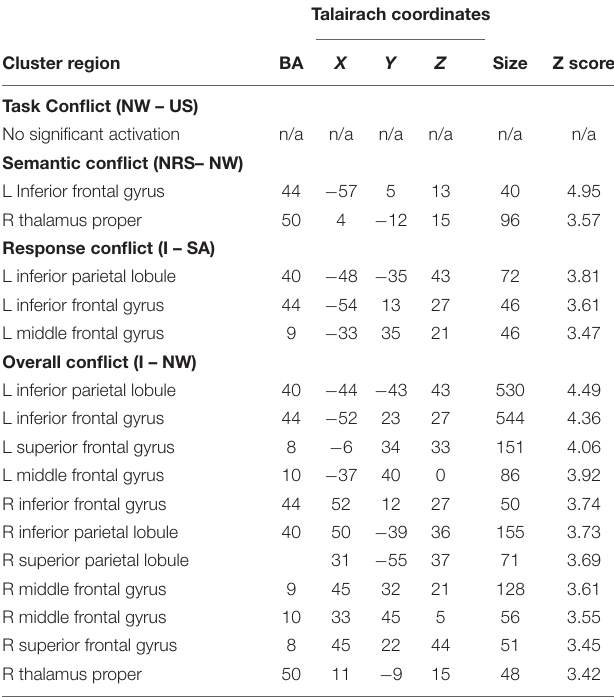
TABLE 2 | Activated areas in response to each of the components of Stroop